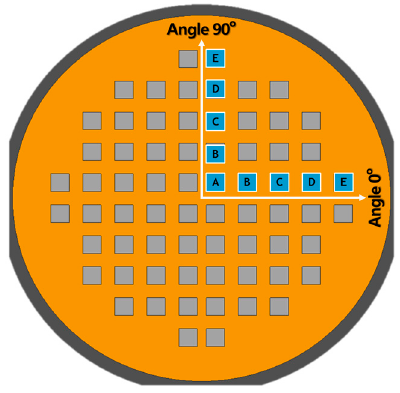
Figure 9. Definition of directions and nomenclature of measuring dies.